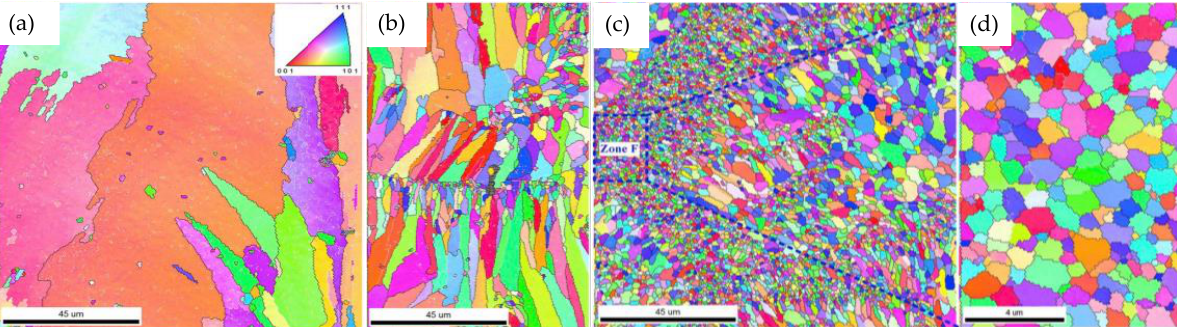
Figure 16. EBSD orientation maps of Sc- and Zr-modified 7075 alloy at different energy densities: ( a ) 44 J/mm 3 ; ( b ) 167 J/mm 3 ; ( c ) 375 J/mm 3 ; ( d ) magnified zone. Reproduced with permission from Elsevier [156].